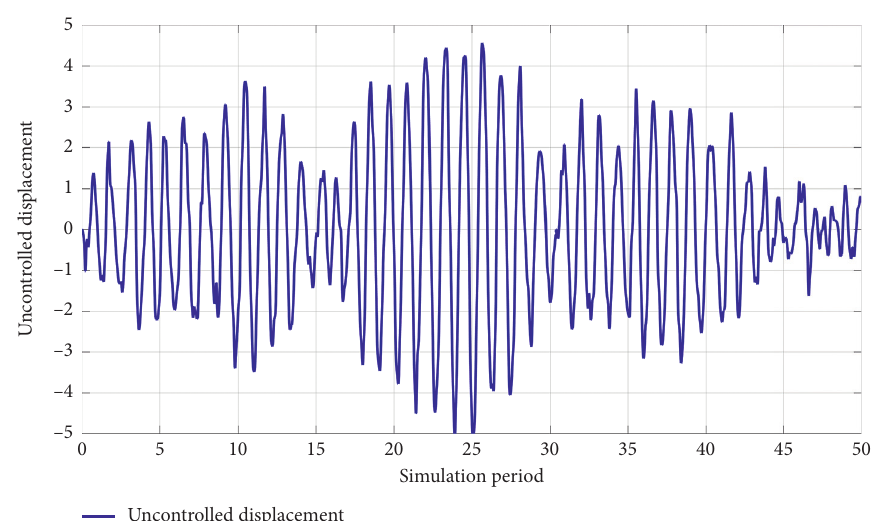
Figure 5: Uncontrolled